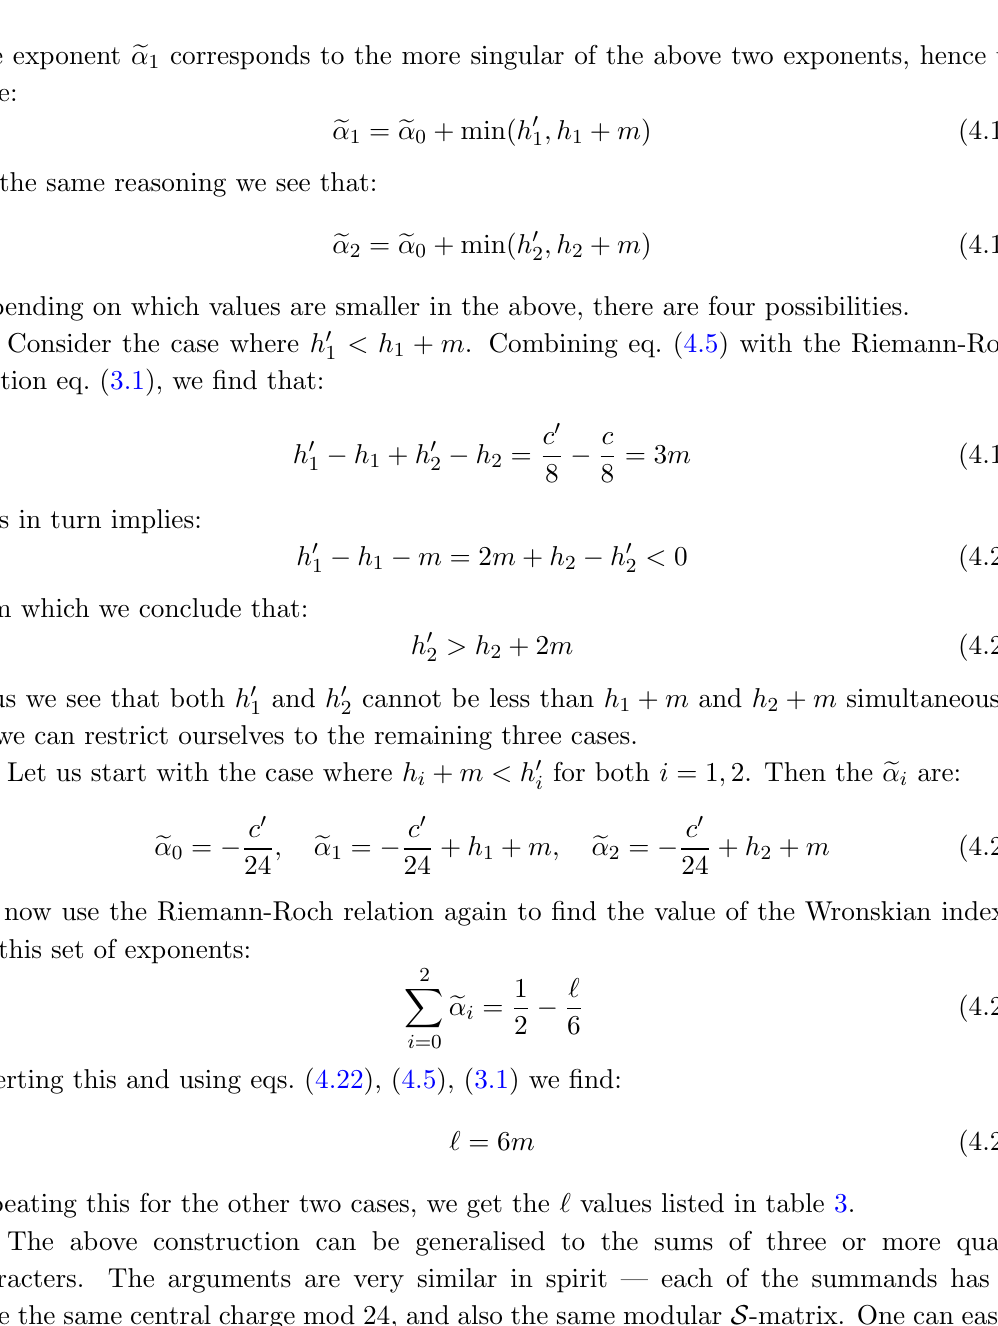
Table 3 . Possible values of the Wronskian index ‘